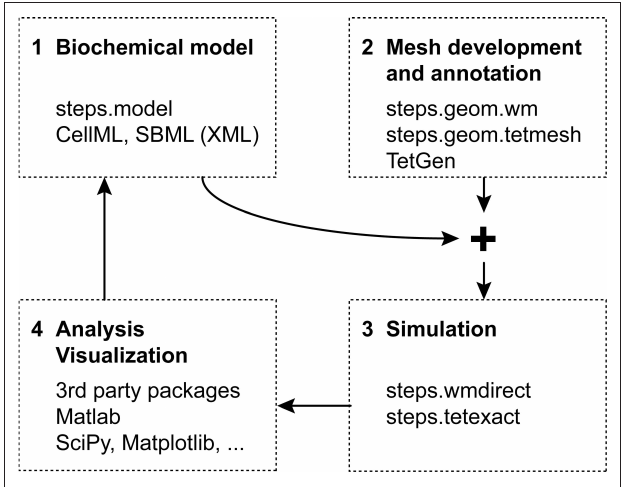
FIGURE 1 | Workfl ow for reaction-diffusion modeling with four phases.